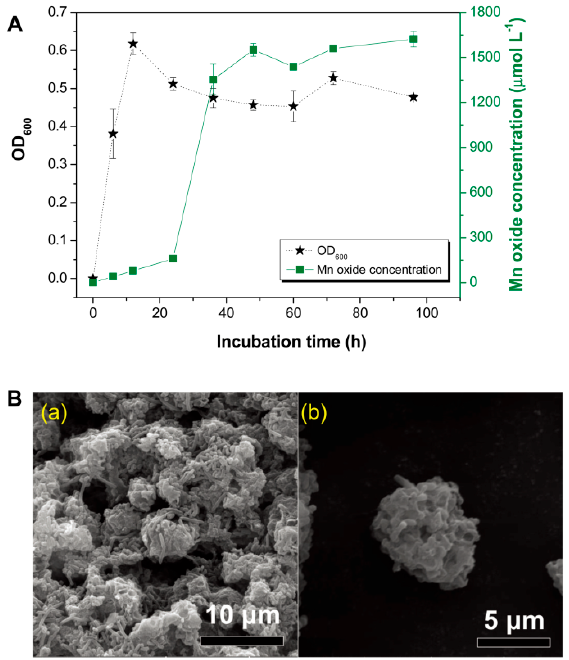
Figure 1. ( A ) Timecourse of Mn 2+ -oxidizing activity of the BMO cultures; ( B ) SEM micrograph of the formed aggregates in 48 h cultures ( a ); and SEM micrograph of a representative aggregate ( b ). XRD assays were performed to verify the types of Mn oxides in the microspherical